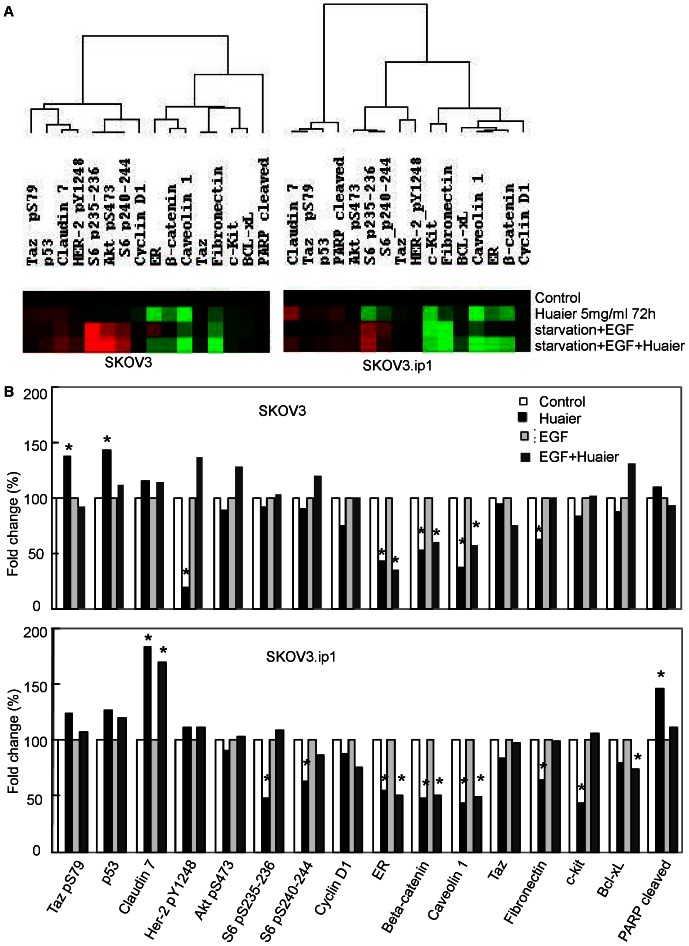
Huaier regulates proteins related to cell proliferation, apoptosis and cell adhesion or invasion in ovarian cancer cells, as detected by the reverse phase protein array (RPPA) assay.(A) Hierarchical cluster analysis of four samples (control, Huaier-treated for 72 hours, starvation+EGF stimulation, starvation +EGF stimulation+Huaier for 60 hours) in SKOV3 and SKOV3.ip1 cells according to the expression of 16 signaling molecules. Cluster color key: red – up-regulated; green – down-regulated; black – unchanged. (B and C): Fold changes in the expression or phosphorylation of various proteins after Huaier treatment and addition of EGF were analyzed using the RPPA assay in the SKOV3 (B) and SKOV3.ip1 (C) cells. The relative values of the control group and the starvation+EGF stimulation groups were set as 1.0. *: fold change>30%.